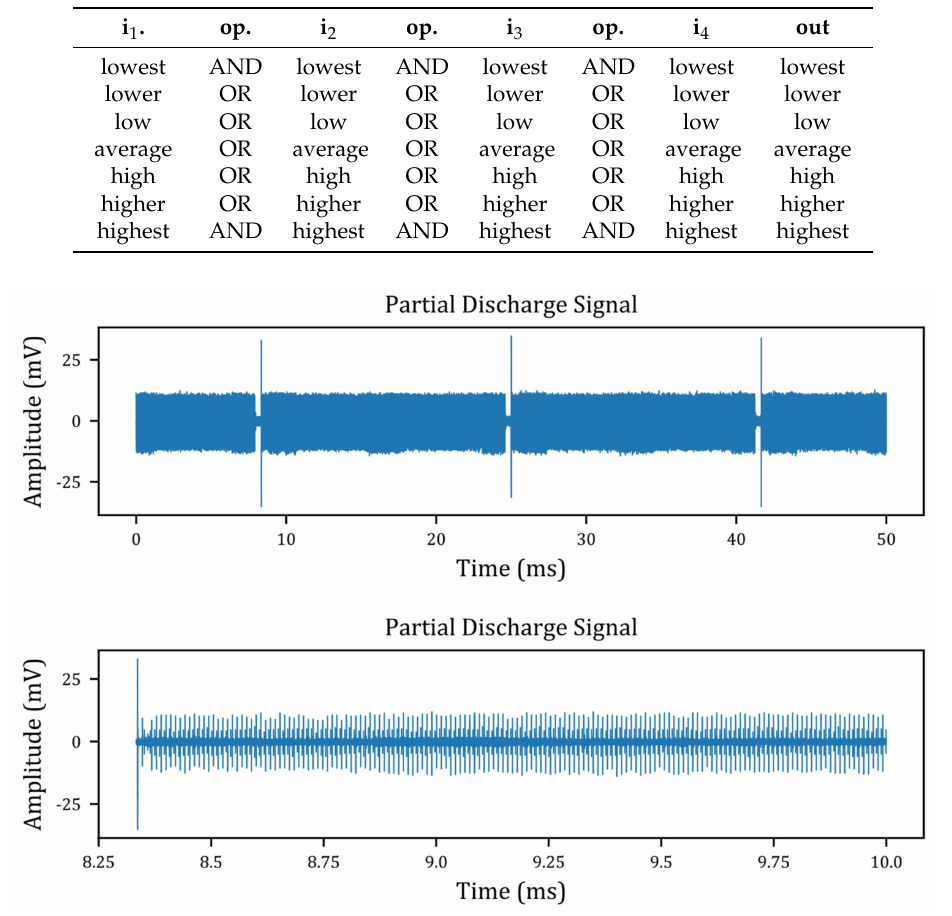
Figure 4. Example of a signal collected at a substation, referenced to three power frequency cycles ( top ) and in detail showing individual partial discharge pulses ( bottom